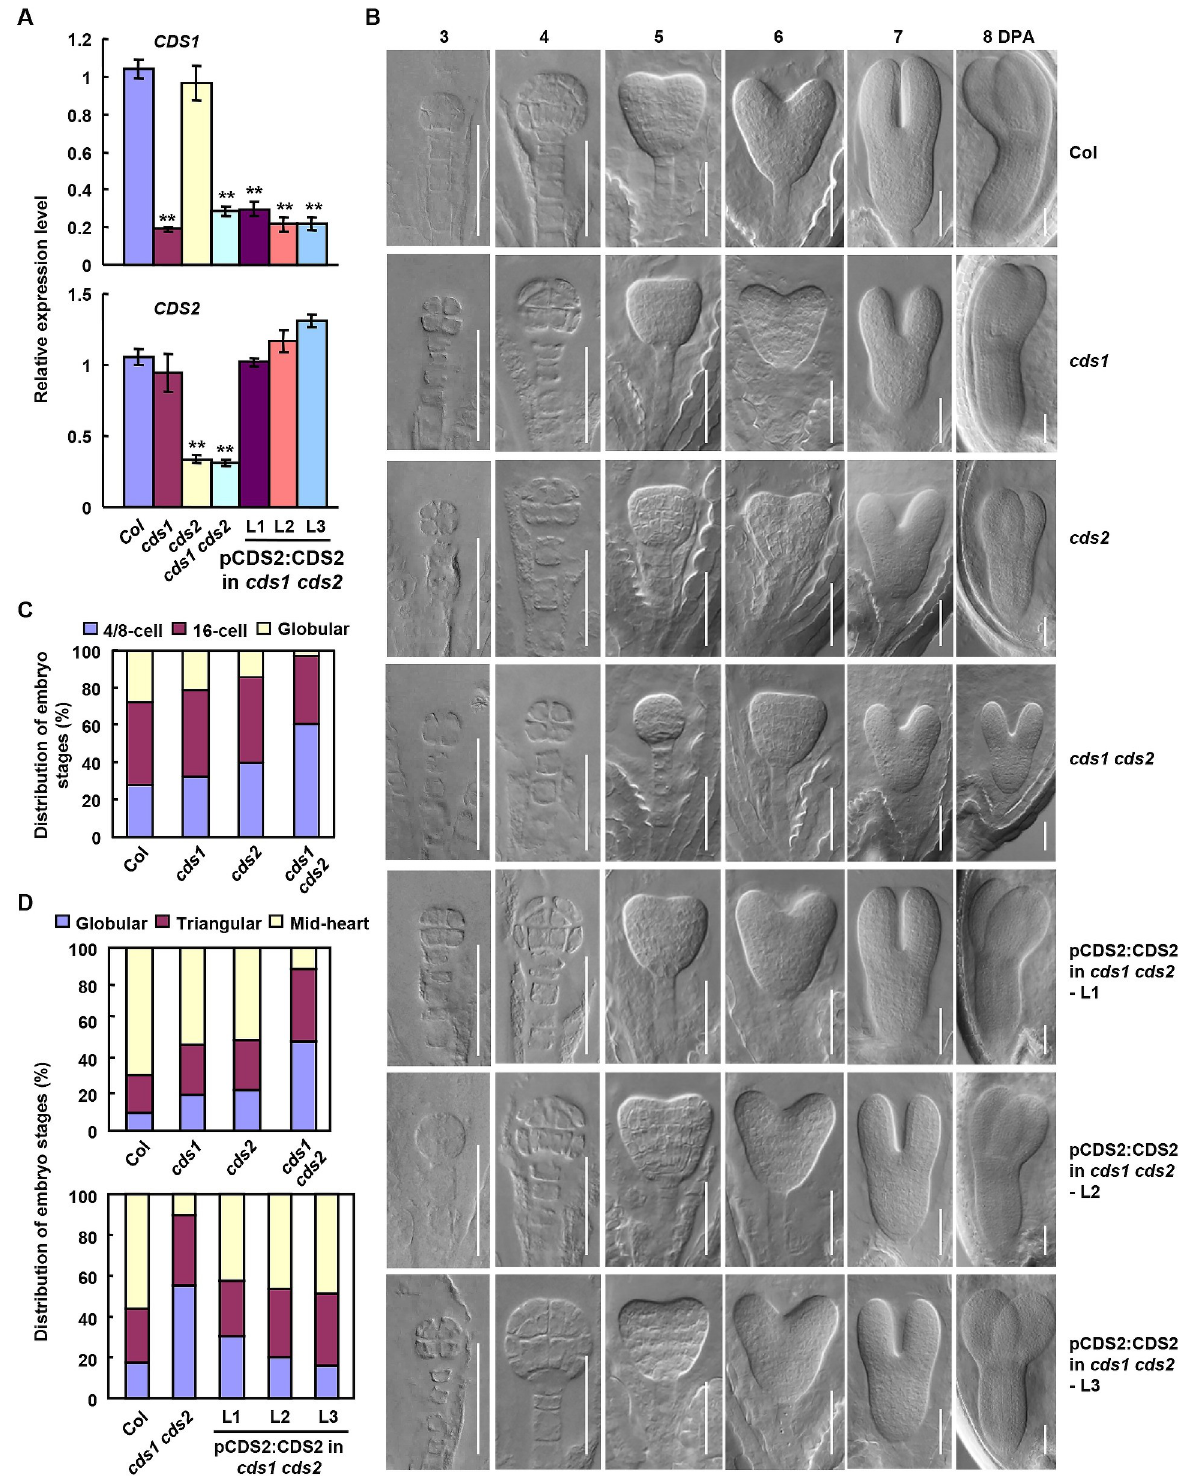
Fig 3. Suppressed expression of CDS1 and CDS2 resulted in the defective embryonic development. (A) RT-qPCR analysis of transcriptions of CDS1 and CDS2 genes in Col, various mutants, and cds1 cds2 plants with complemented expression of CDS2 driven by native promoter. ACTIN2/8 was amplified and used as an internal reference to normalize the expressions of CDS1 and CDS2 . Experiments were biologically repeated for two times and data were mean ± SE. Statistical significance was determined by student’s t test ( �� , P < 0.01). (B) Embryo development of Col, cds1 , cds2 ,